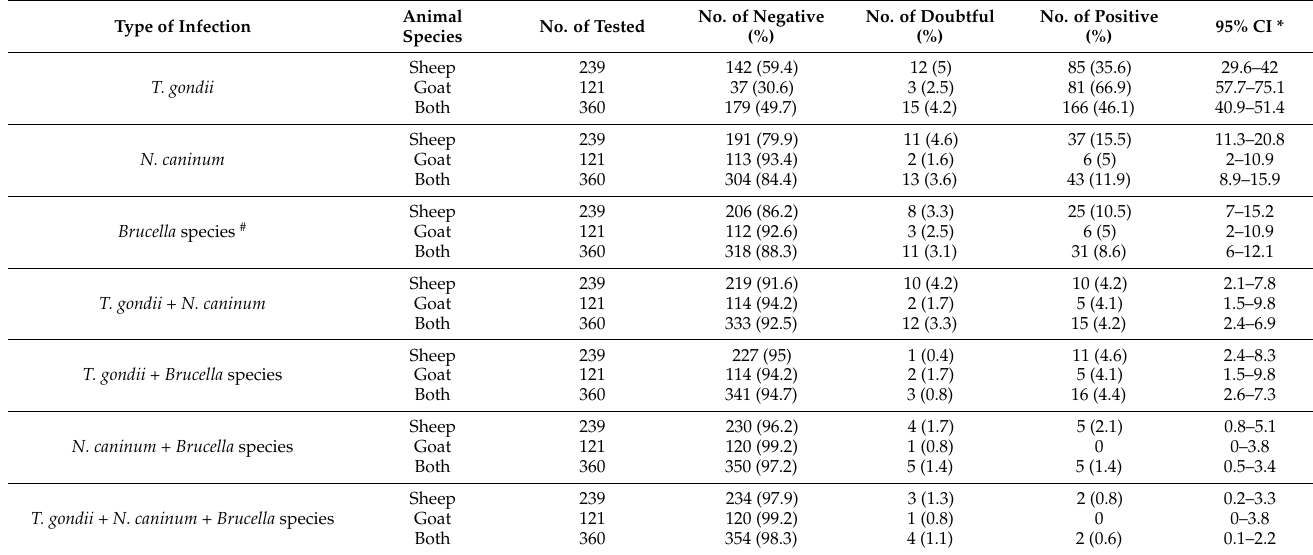
Table 3. Seroprevalence of T. gondii , N. caninum , Brucella spp., and mixed infections in sheep and goats from Egypt.